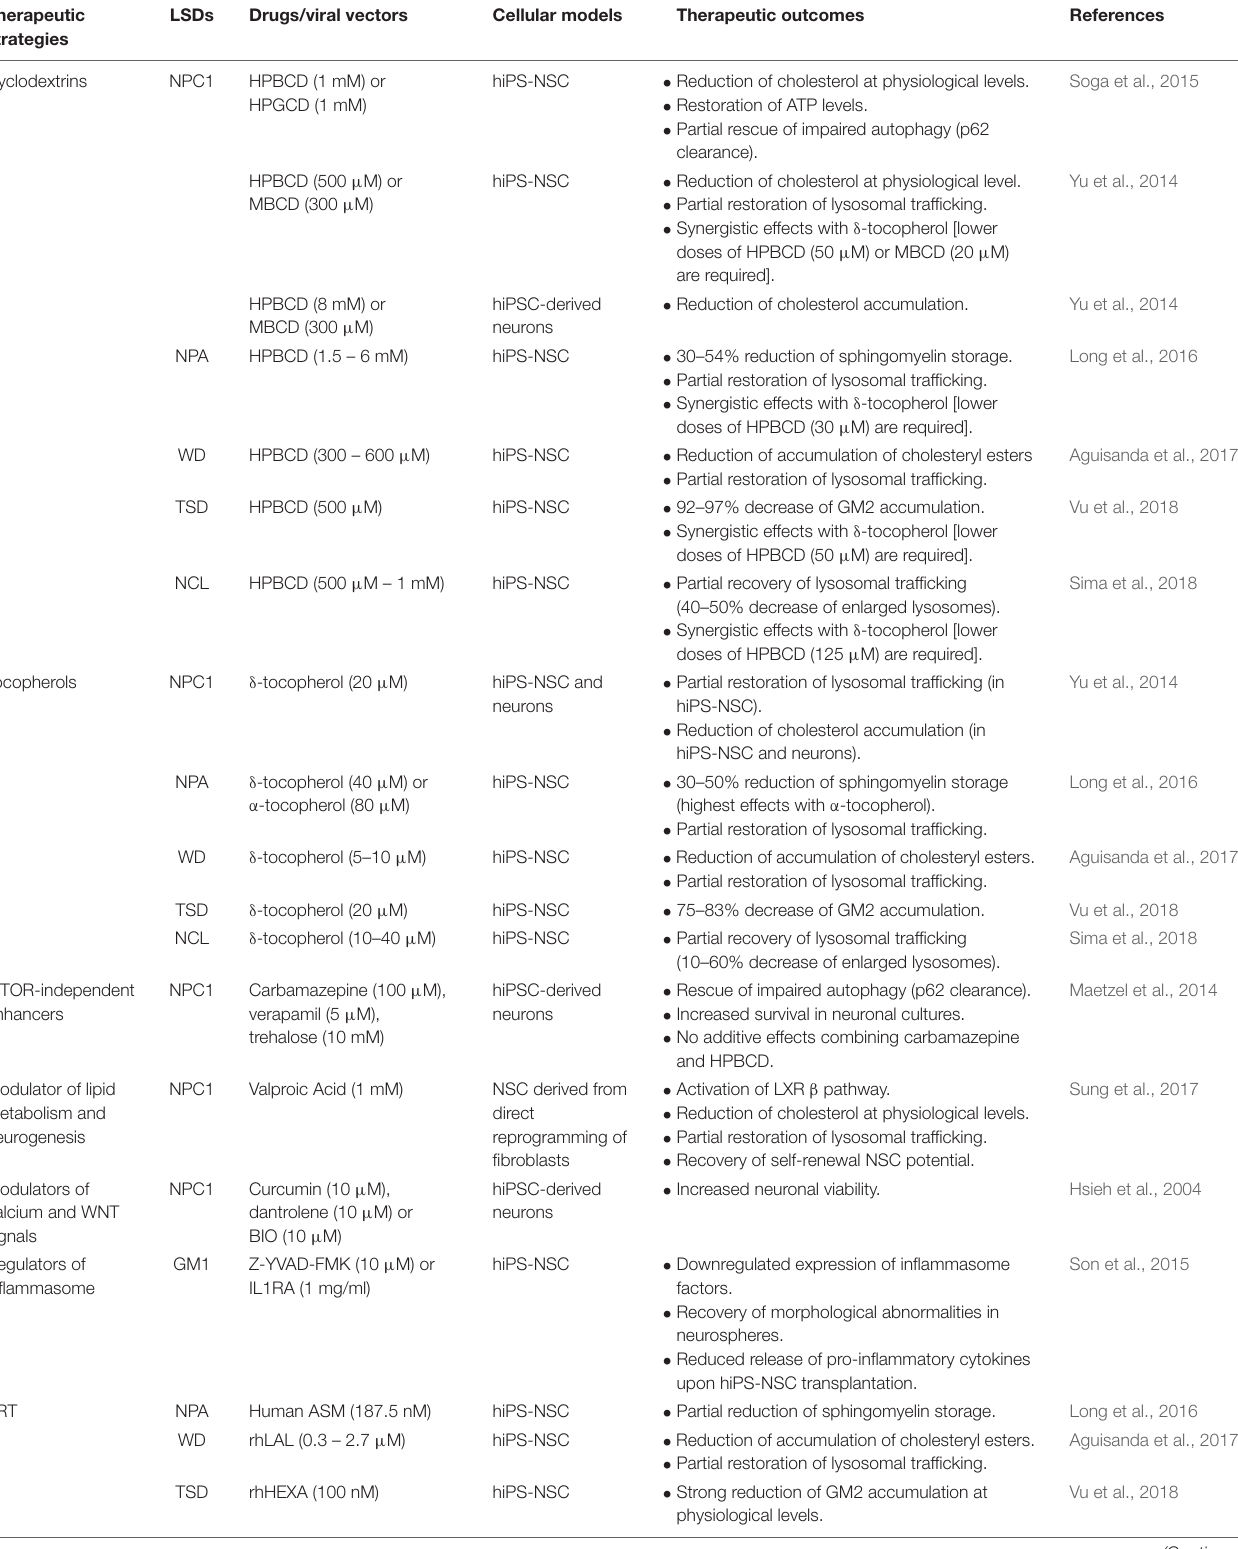
TABLE 1 | List of therapeutic strategies applied in hiPSC-derived models to treat primary biochemical defects and secondary pathological dysfunctions in